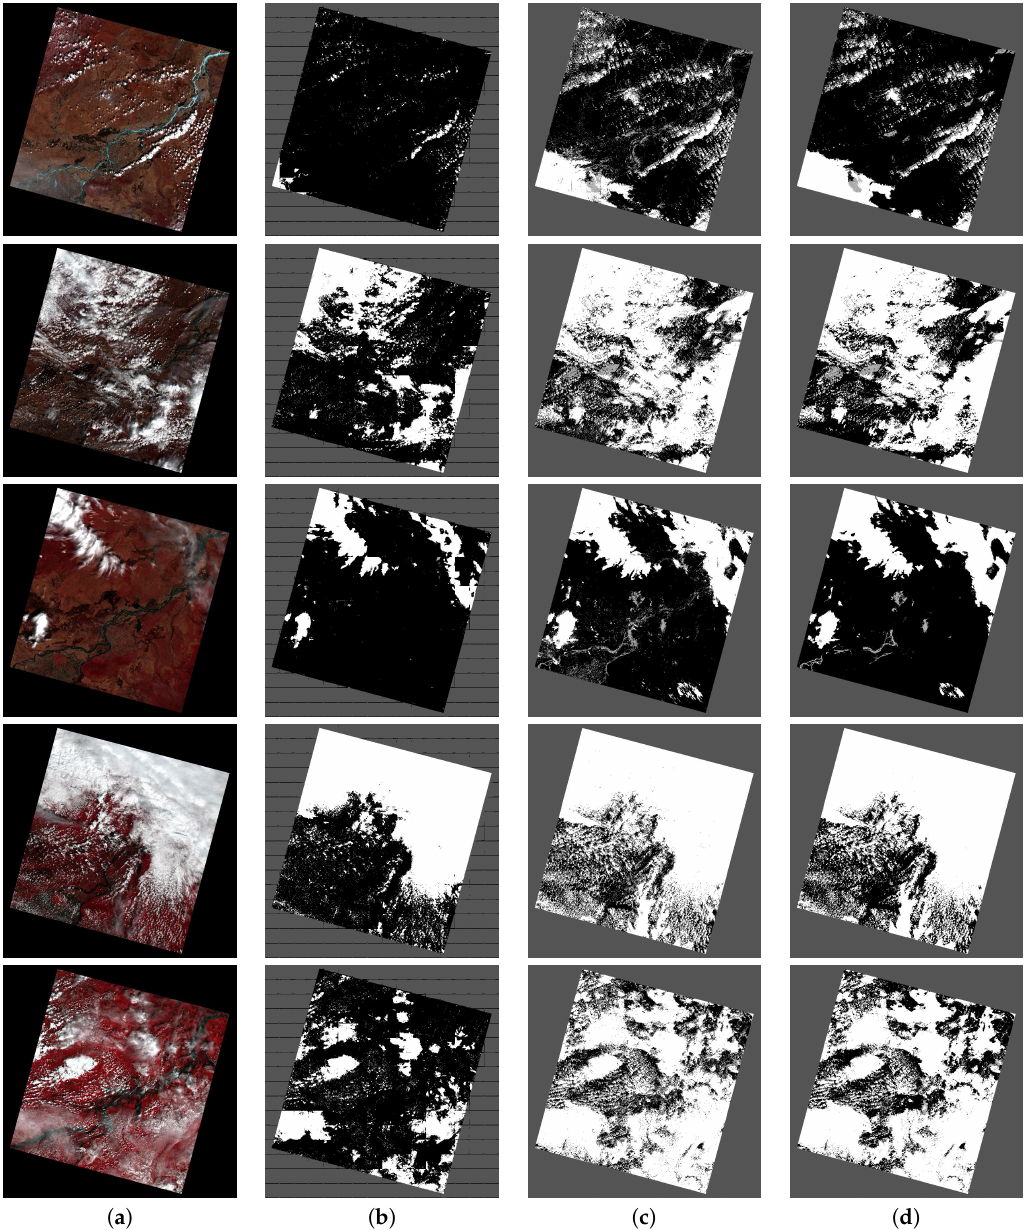
Figure 5. Visualizations of cloud and cloud shadow segmentation (L8, Path 113, Row 26): ( a ) false-color image; ( b ) PSPNet; ( c ) UNet (the backbone net); and ( d ) refined UNet. Bands 5 NIR, 4 Red, and 3 Green are combined together as RGB channels to construct a false-color image for